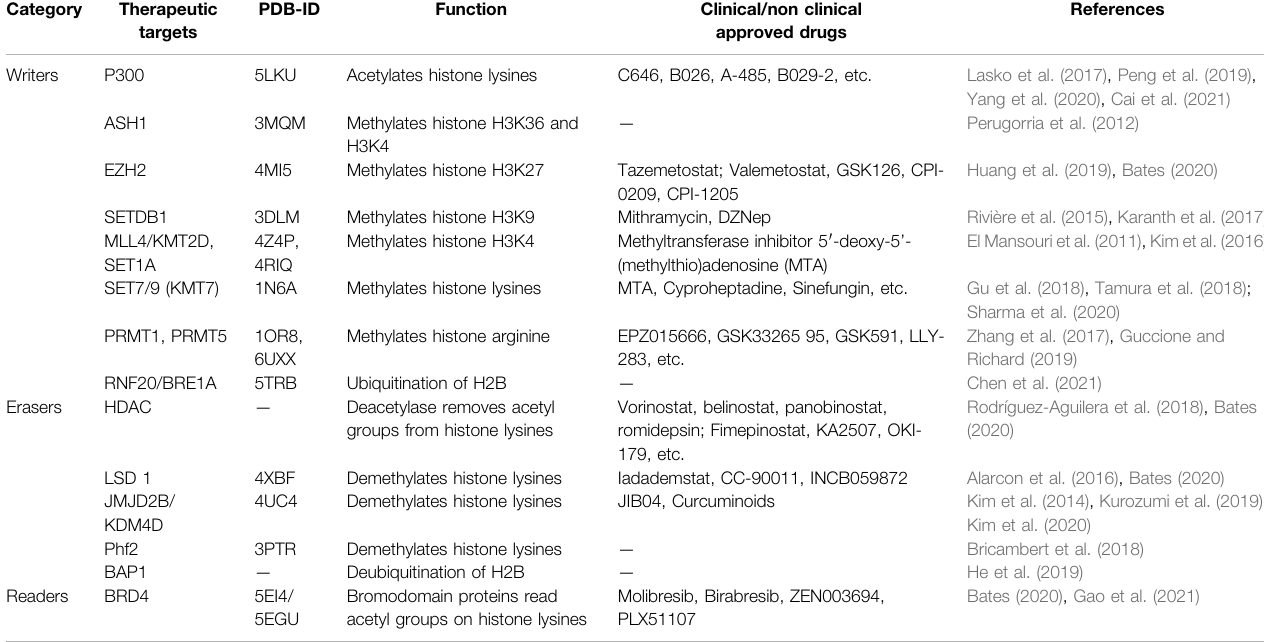
TABLE 2 | Summary of potential therapeutic targets and the corresponding clinical approved/non-approved